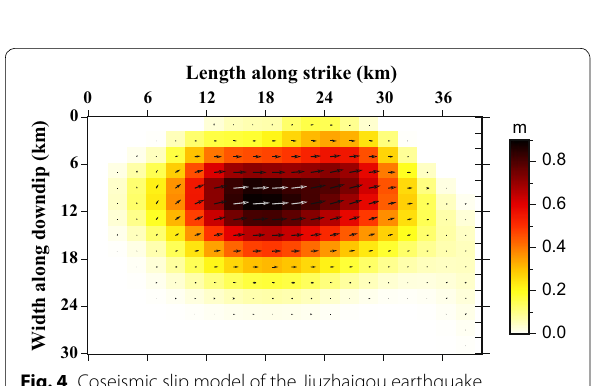
Fig. 4 Coseismic slip model of the Jiuzhaigou earthquake